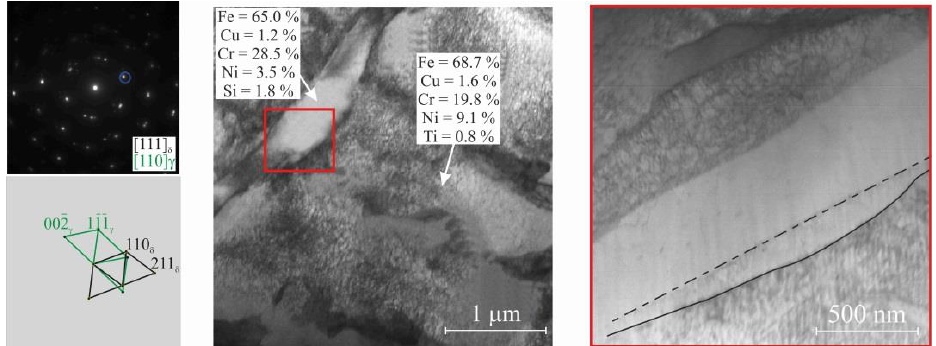
Figure 7. SAED pattern with interpretation and dark-field TEM image for steel areas. The elemental compositions of the γ- and δ-Fe regions in wt. % revealed by EDS analysis. The typical composition of the ferrite phase is Fe-(27.2–29.3)Cr-(3.2–3.8)Ni (wt. %). The red rectangle marks the enlarged zone of δ-ferrite lamellae, the boundaries of which are partially curved.